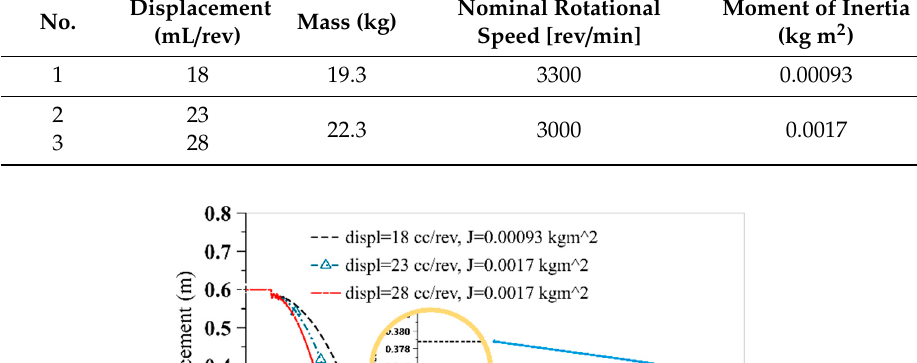
Table 5. Simulation parameters of PM for the FFERS.